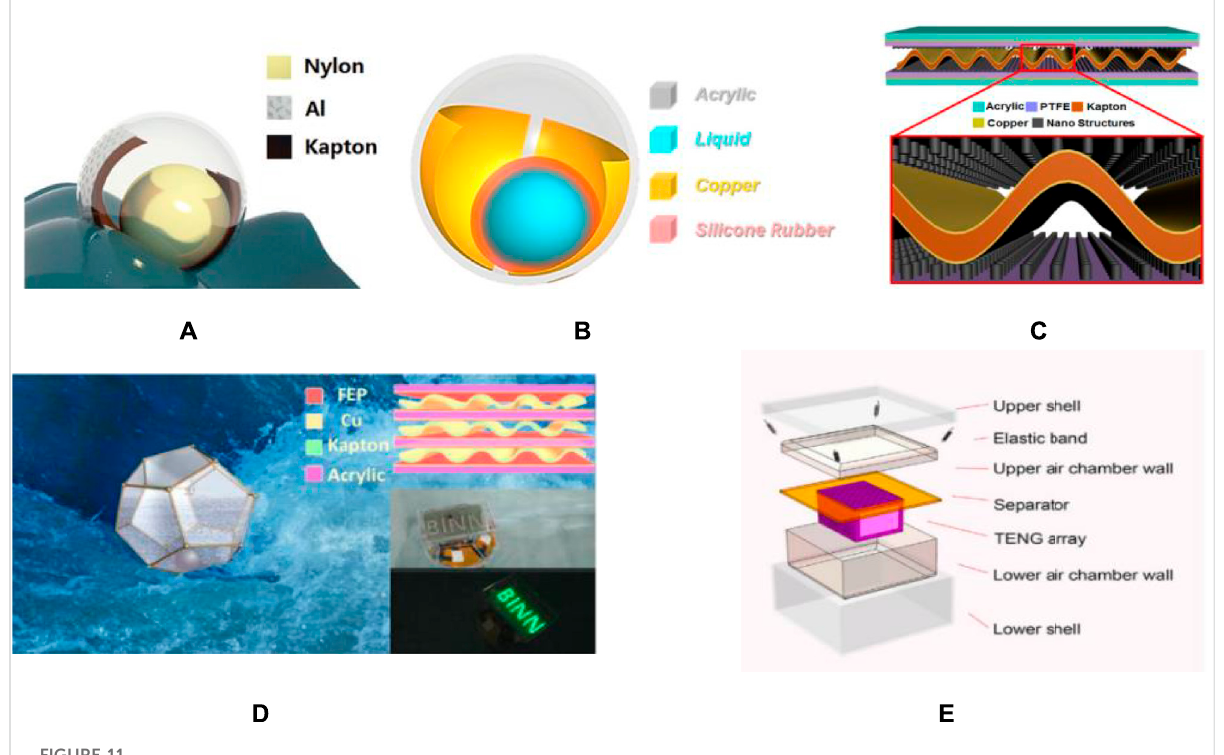
FIGURE 11 Fully enclosed TENG (A) Schematic diagram of the RF-TENG structure (Wang X et al., 2015). (B) Schematic diagram of SS-TENG structure (Cheng et al., 2019). (C) Schematic diagram of the wave-like TENG structure (Wen et al., 2014). (D) Schematic diagram of WS-TENGs (Zhang et al., 2016). (E) Schematic diagram of an integrated TENG array device based on an air-driven membrane structure (Xu et al.,